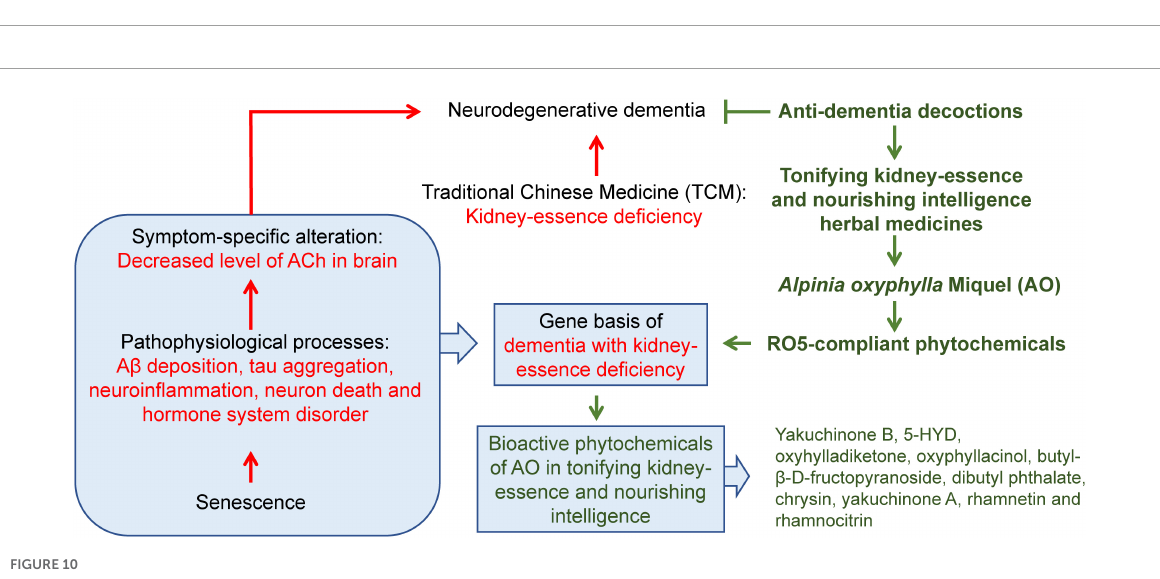
FIGURE9 The phytochemicals and targets of AO in treating neurodegenerative dementia. (A) Bubble plot showing the number of phytochemicals of AO targeting tau degradation, ACHE/BCHE, A β production and degradation, tau phosphorylation, neuroinflammation, and neuron death. The x -axis, AD Ratio (the ratio of the targets in the total targets). Bubble size, the number of AO phytochemicals. Bubble color, the number of targets. (B) Frequency distribution of AO phytochemicals with different numbers of anti-AD targets. (C) Heatmap summarizes the number of targets for AO phytochemicals regulating different pathological processes. X indicates not applicable. The red numbers represent the total number of targets involved in each row in the heatmap.